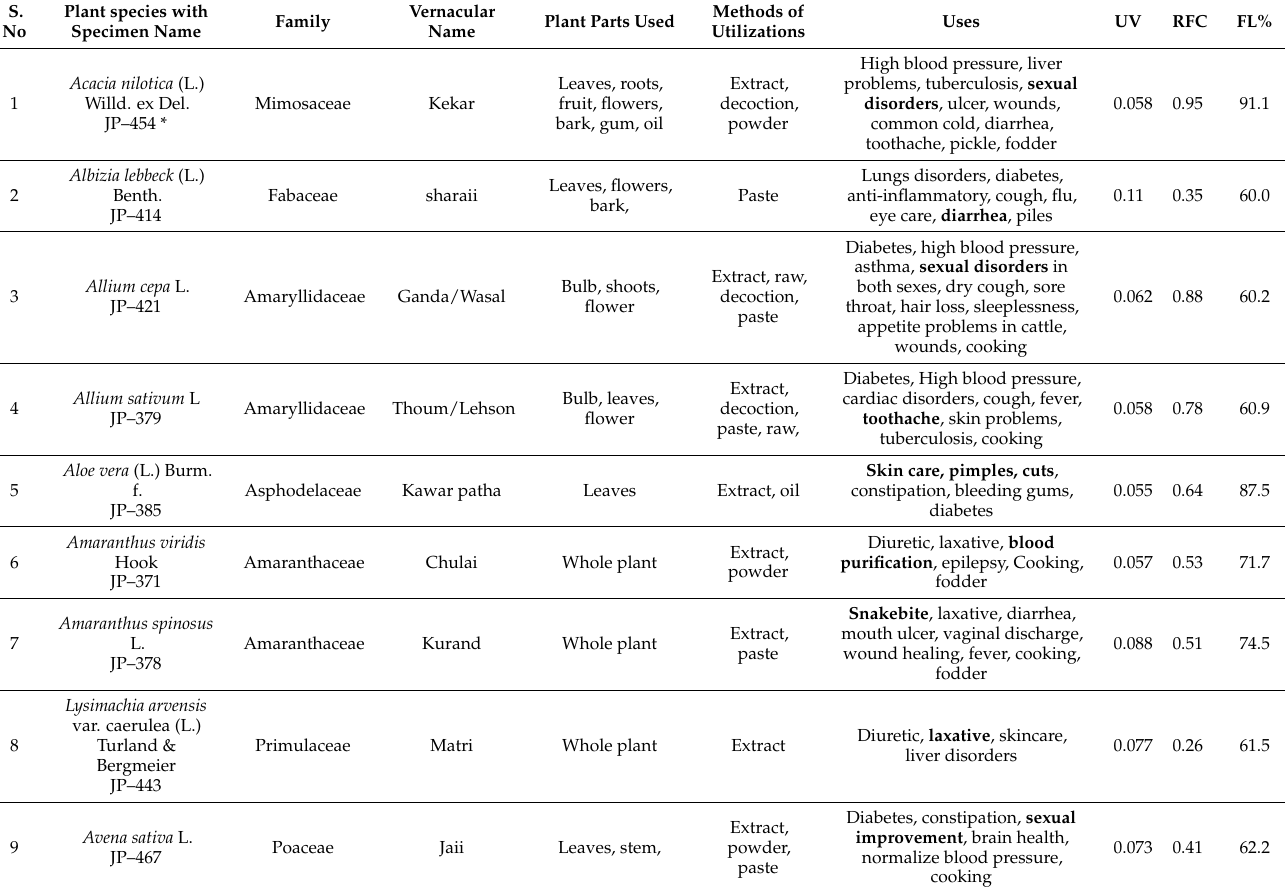
Table 4. Plants from the study areas with medicinal